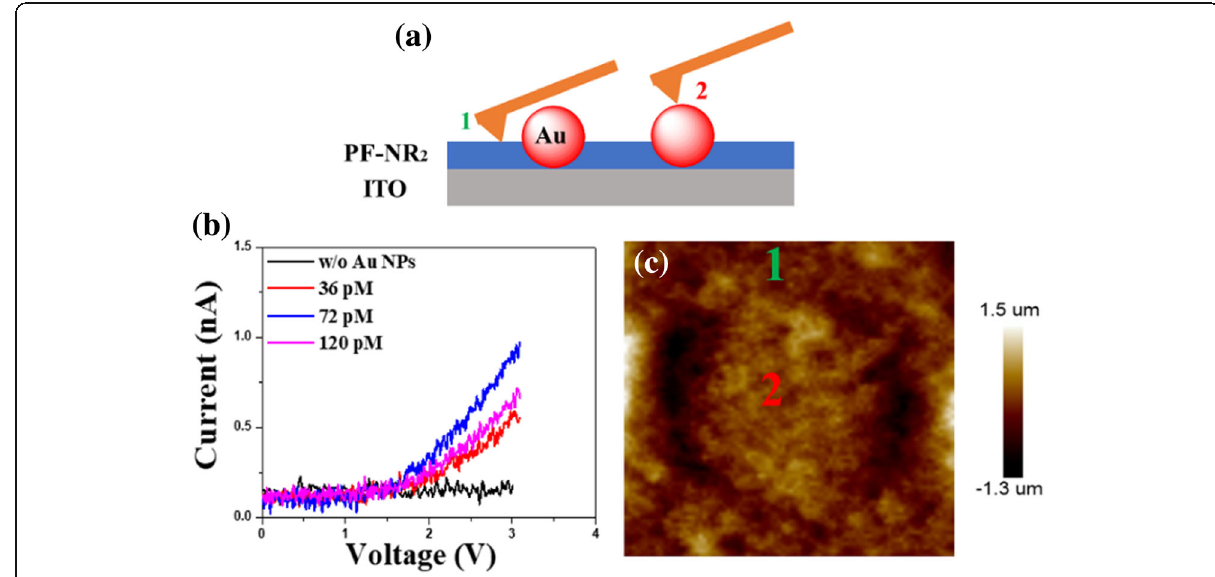
Fig. 4 a Schematic of c-AFM testing. b , c I-V characteristics near a single Au NPs and the depiction of the height of a single Au NP in PF-NR 2 layer. The locations of the colored numbers in the inset image correspond to the color of the I-V